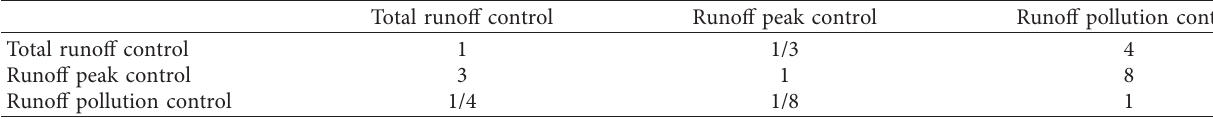
Table 12: Index scale table of the rainwater control effect plan.